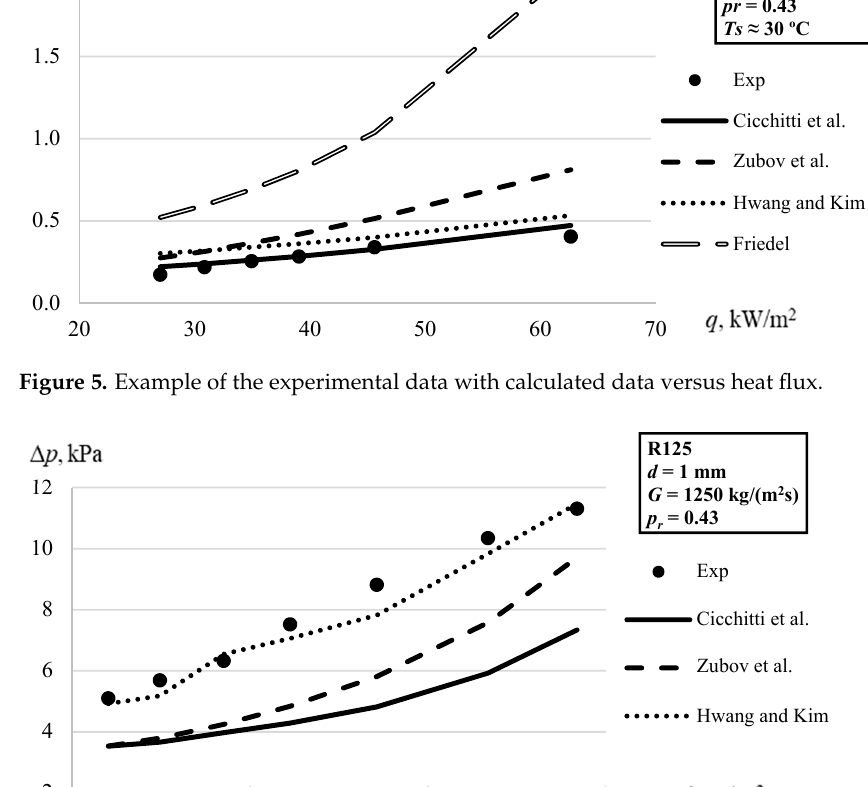
Table 3. Comparison of obtained pressure drop databases with predictions of selected correlation. p r